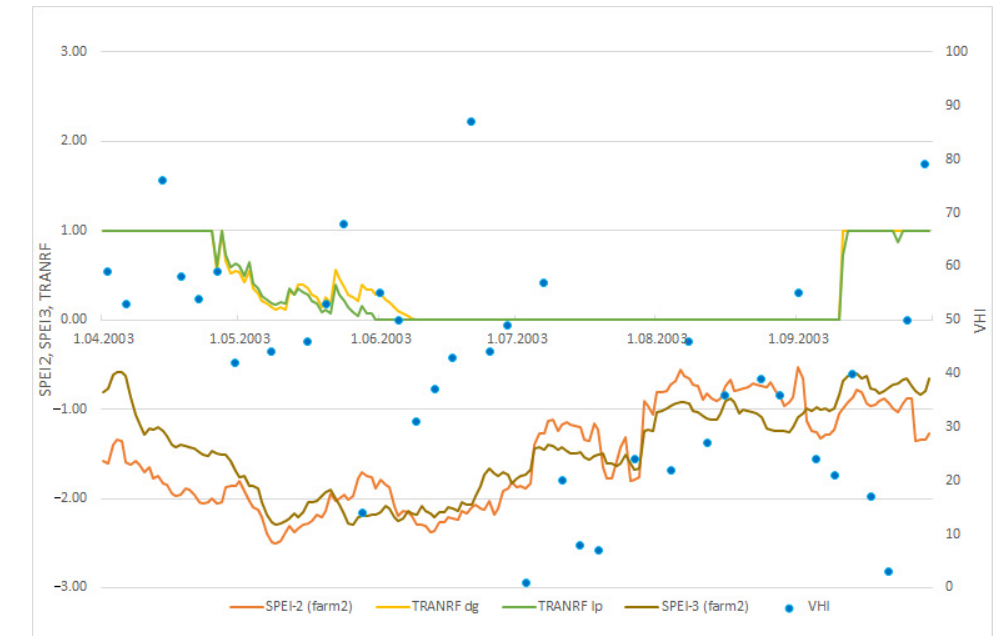
Figure 9. Time series of the LINGRA-N model results of drought factor (TRANRF) using the parameter set calibrated for Dactylis glomerata in Jablje (dg) and Lolium perenne in Jablje (lp); time series of drought indices (VHI, SPEI-2 and SPEI-3) for Farm2, all for 2003. Comparison of SPEI-2 and SPEI-3 Indices with TRANRF, SMACT, WRE, and WRT Table 3. Statistical analysis of drought index SPEI-3 at Farms1e and 1i and the LINGRA-N model results of yield (TRANRF, SMACT, WRE, WRT) for year 2017—shown are values of r 2 .